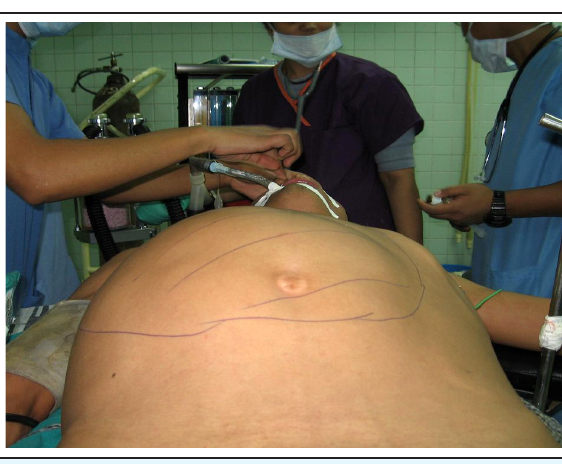
figure 1. showing extent of the abdominal lump on examination.